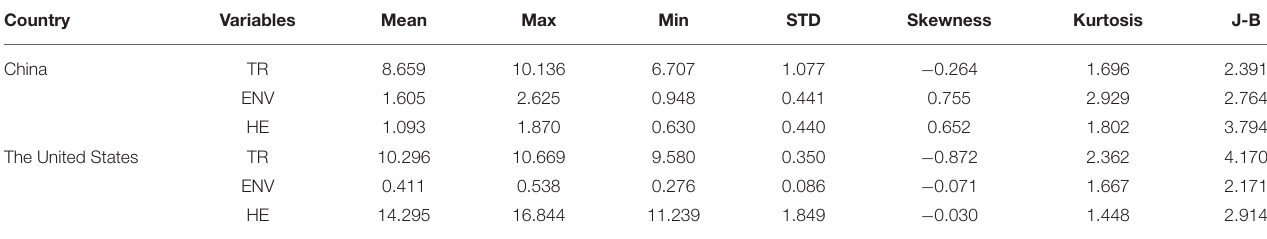
TABLE 1 | Summary Statistics of the variables. Country